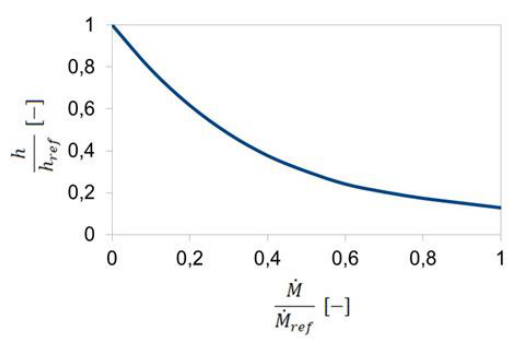
Fig. 4. The average fouling thickness h/h ref vs. mass flow in EGR valve Ṁ /Ṁ